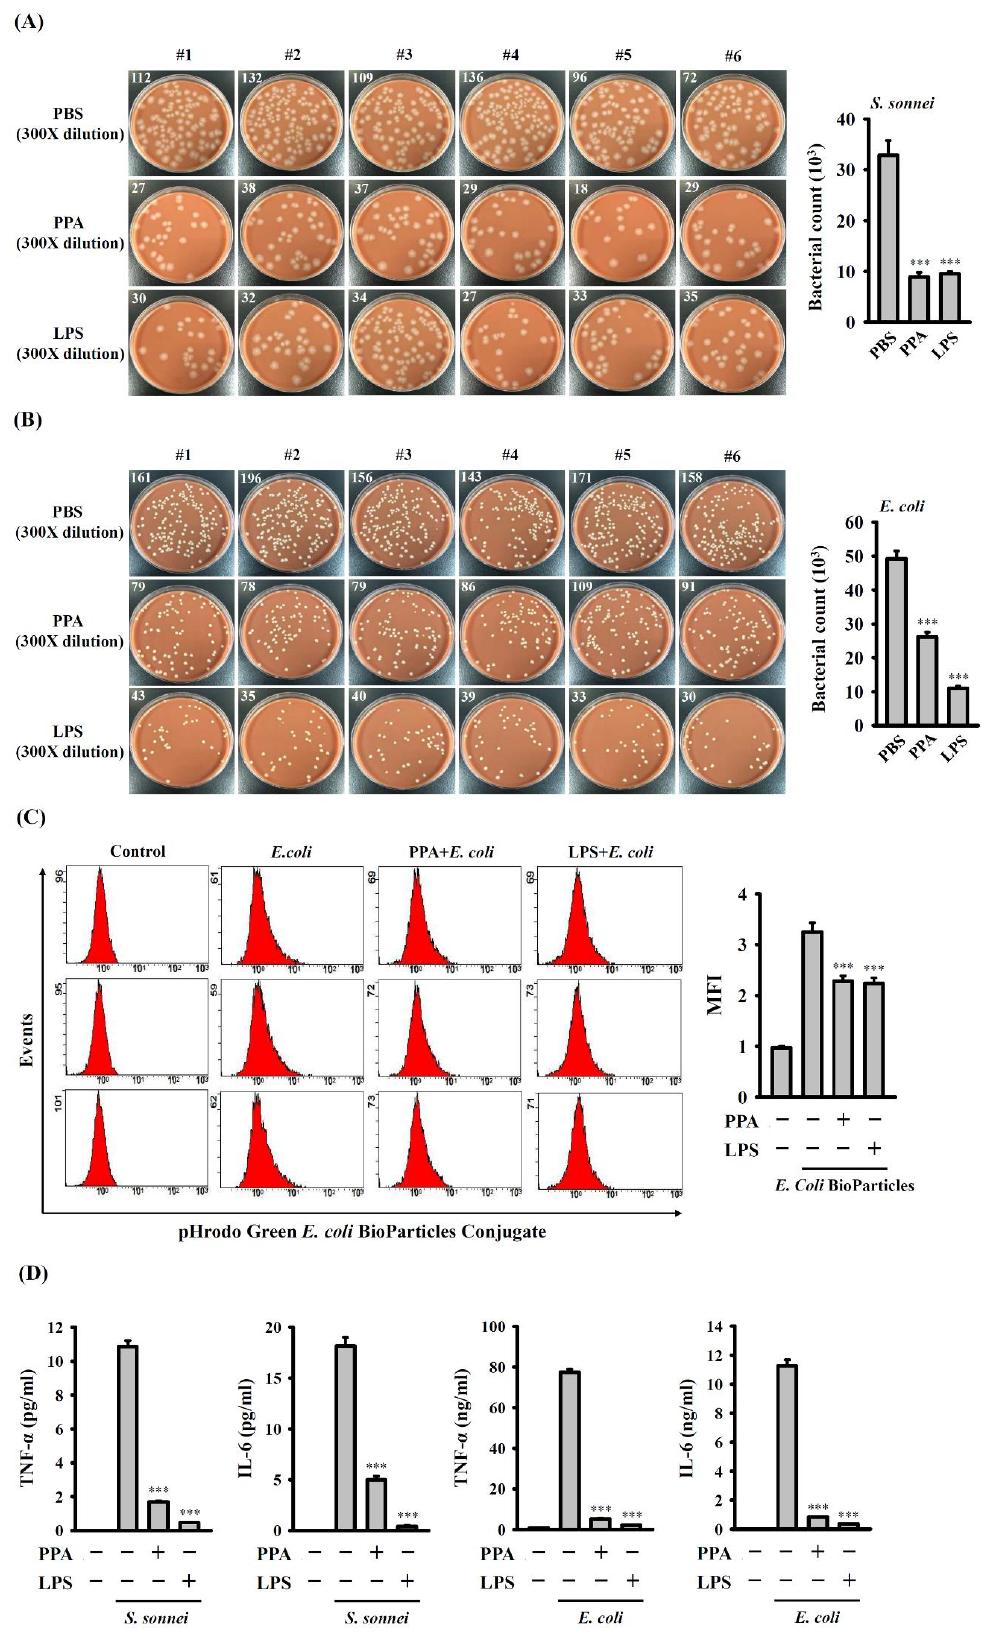
Figure 9. PPA reduces the phagocytic activity and cytokine production of J774A.1 macrophages in response to bacterial infection. ( A – C ) Effect of PPA on the phagocytic activity of cells in response to ( A ) S. sonnei infection, ( B ) E. coli infection